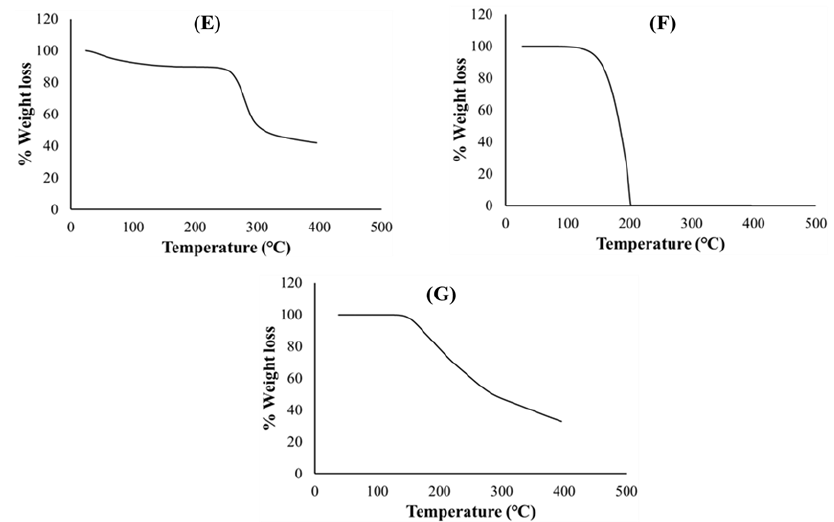
Figure 4. Thermogravimetric curves of ( A ) PZA, ( B ) xylitol, ( C ) citric acid, ( D ) polyvinyl alcohol polyethylene glycol, ( E ) sodium starch glycolate, ( F ) drug loaded formulation and ( G ) placebo. Int. J. Mol. Sci. 2020 , 21 , x FOR PEER REVIEW